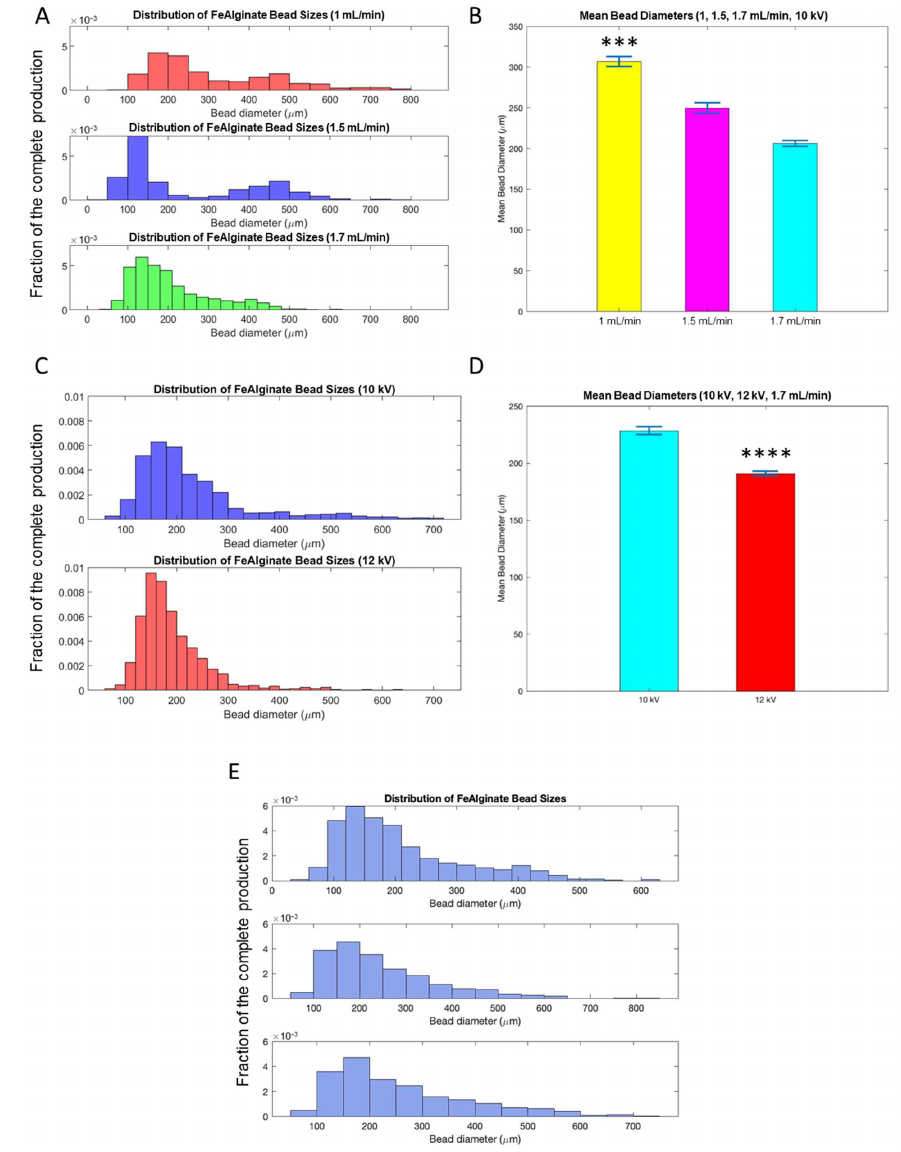
Figure 5. Optimization of electrospray parameters for the production of Fe-Micro beads. Comparison between different flow rates, distribution of bead diameter ( A ) and mean bead diameter in a batch ( B ). Comparison between different voltage, distribution of bead diameter ( C ) and mean bead diameter in a batch ( D ). Distribution of bead diameter of three independent batches ( E ). Mean and standard error of mean. *** p < 0.001, **** p <